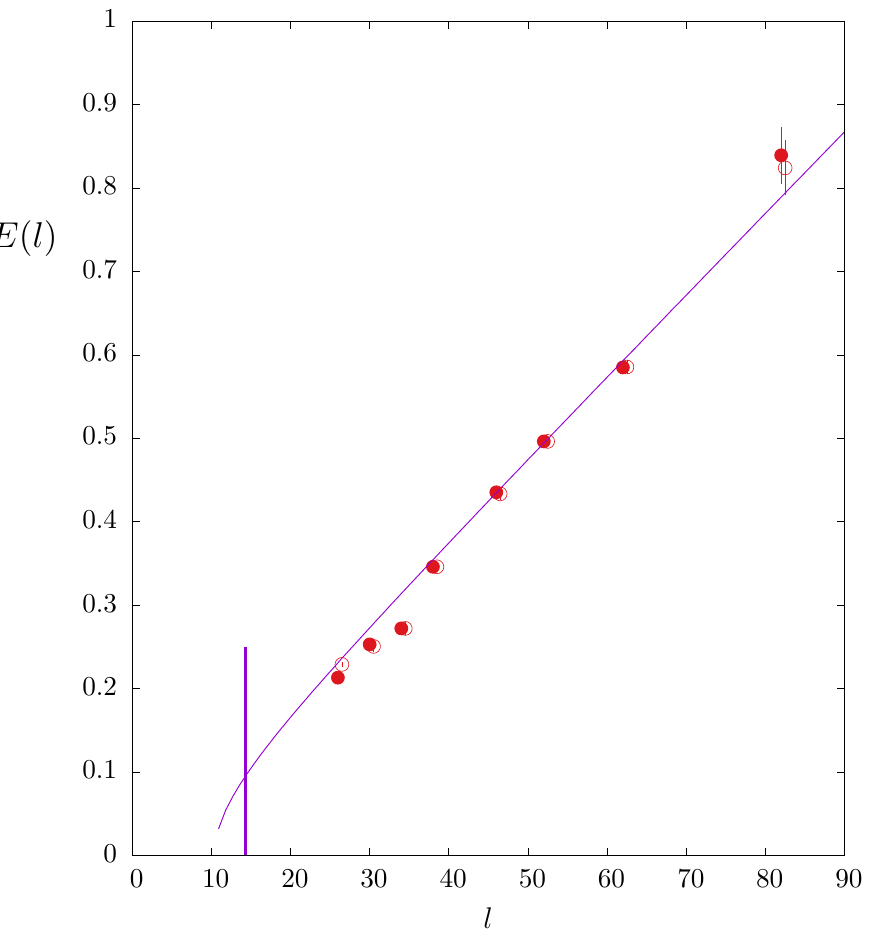
Figure 14 . Ground state energy of a (cid:13)ux tube of length l in SO(3) at (cid:12) = 9 : 0 with ( (cid:15) ) and without ( (cid:14) ) vacuum subtraction. Nambu-Goto (cid:12)t shown. Vertical line gives location of decon(cid:12)ning